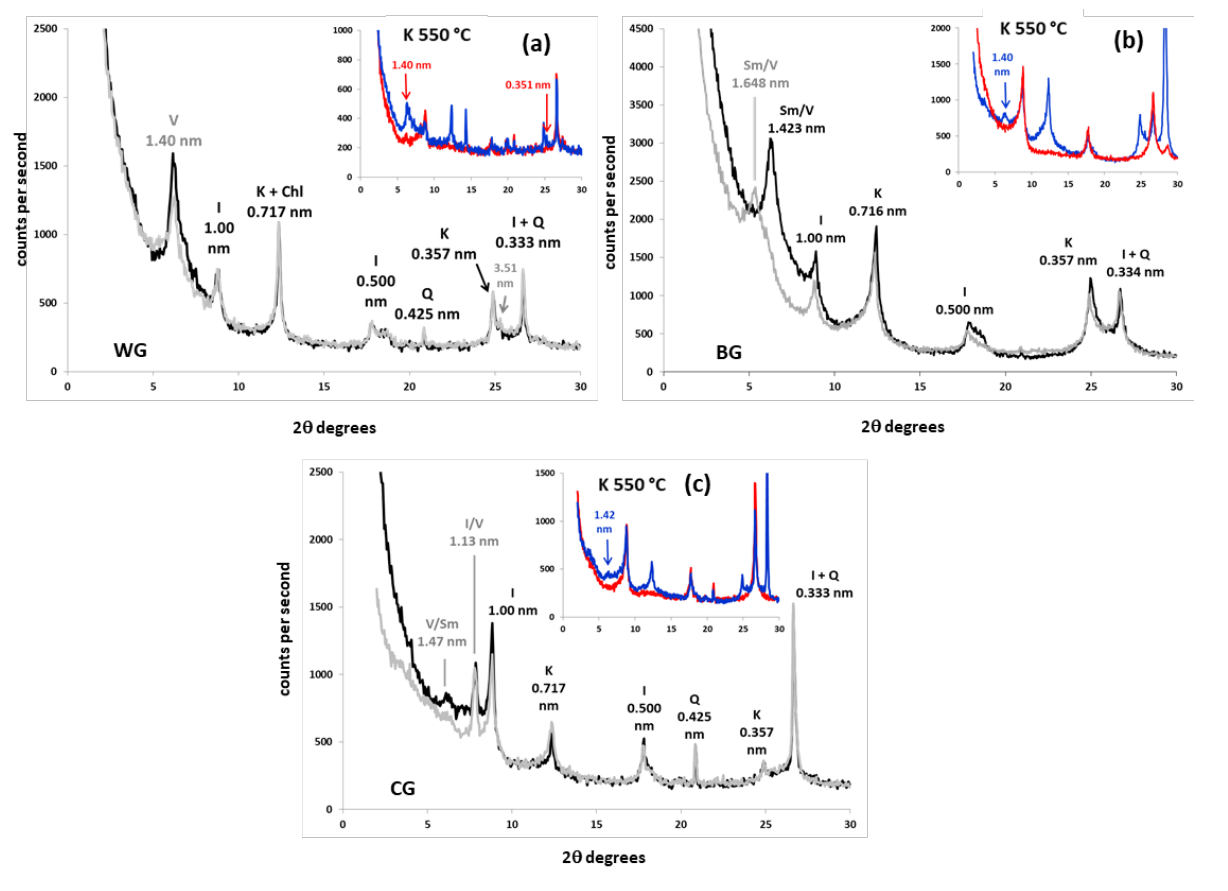
Figure 2. XRD patterns of oriented mounts (3 – 30 °C 2θ) from clay fraction of the siliceous soils with different treatments (black: Mg-saturated and air dried; grey: Mg-saturated and EG-solvated; blue: K-saturated and air dried; red: K-saturated and heated at 550 °C). ( a ) Woodland soil over granodiorite (WG); ( b ) bare soil over granodiorite (BG); ( c ) cover-crop soil over granodiorite (CG). Q: quartz; Sm/V: smectite – vermiculite mixed-layer; V/Sm: vermiculite – smectite mixed layer; V: vermiculite; I/V: illite – vermiculite mixed-layer; I: illite; Chl: chlorite; K: kaolinite. Table 4. Mineralogical composition of clay fraction (DRX- oriented aggregate. Mg-EG. % relative peak area, rpa).